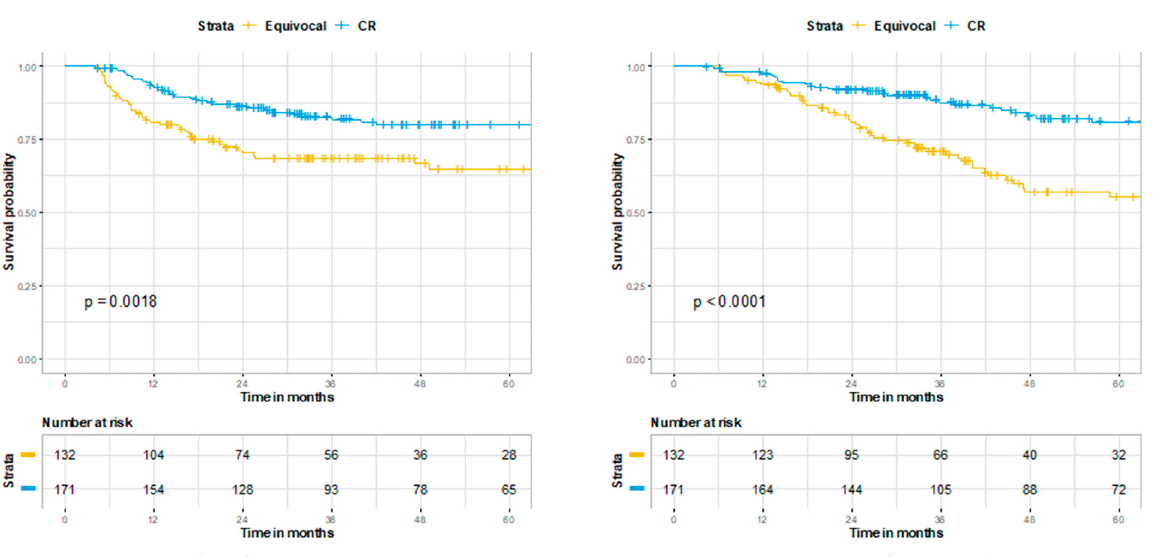
Figure 2. Flowchart of patient responses and clinical outcomes following initial 13 week post-treatment PET/CT scan.